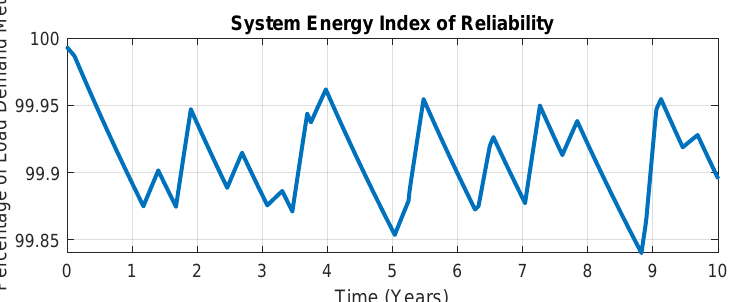
Figure 17. The percentage of probable total load demand met when adopting the replacement policy shown in Figure 16.